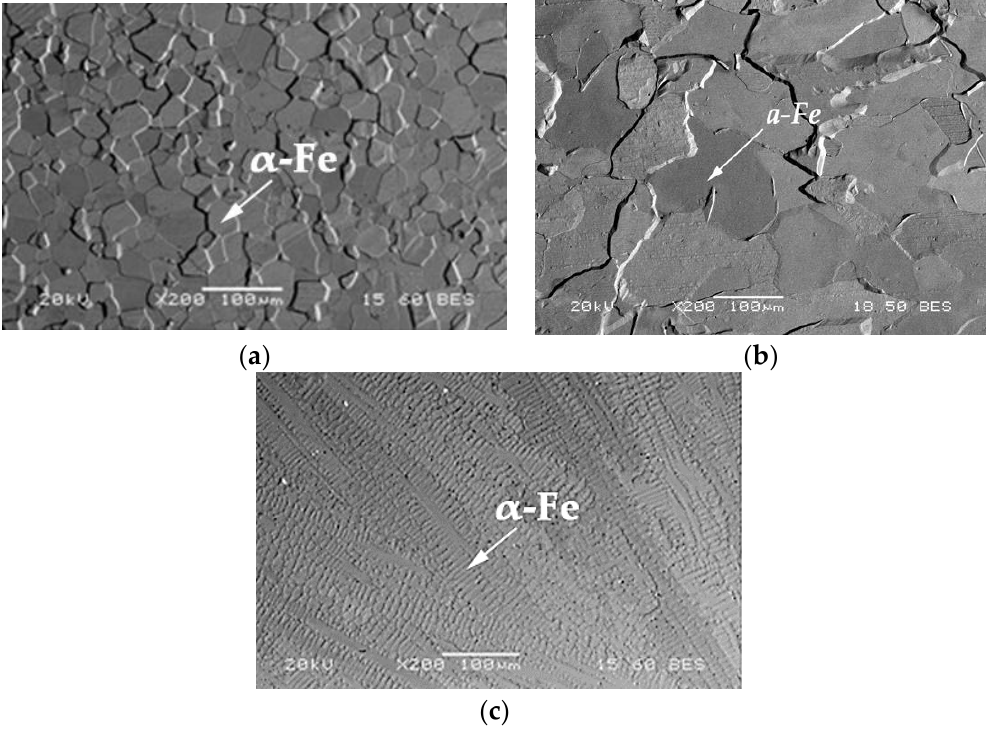
Figure 5. Scanning Electron Microscope (SEM) metallographic images from ( a ) base metal; ( b ) heat affected zone and ( c ) fusion zone of the NOES welded sample ( marked phases: α -Fe: ferrite).